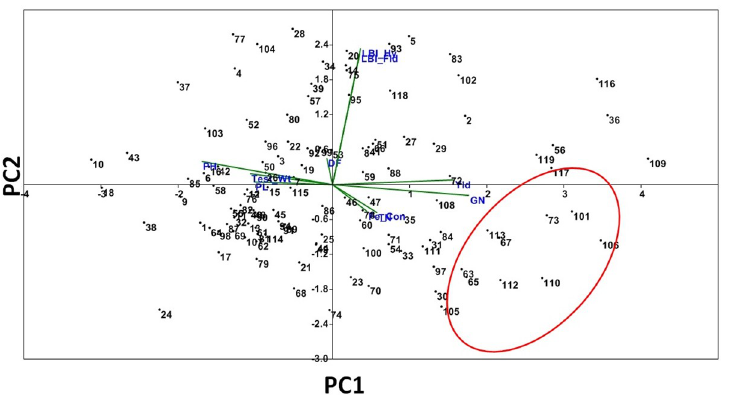
Fig 2. Genotype-by-trait biplot graph depicting genotypes in two main principal components for 9 traits. LBI: Leaf bronzing index; yld: Grain yield (tons/ha); GN: Number of grains/panicle; PH: Plant height (cm); TN: Number of tillers/plant; DFF: Days to 50% flowering; TW: 1000-seed test weight (g); GN: Number of grains/panicle; Fe C: Iron content in grain (ppm). The spot numbers in the graph denotes the genotypes serial number as enlisted in Table